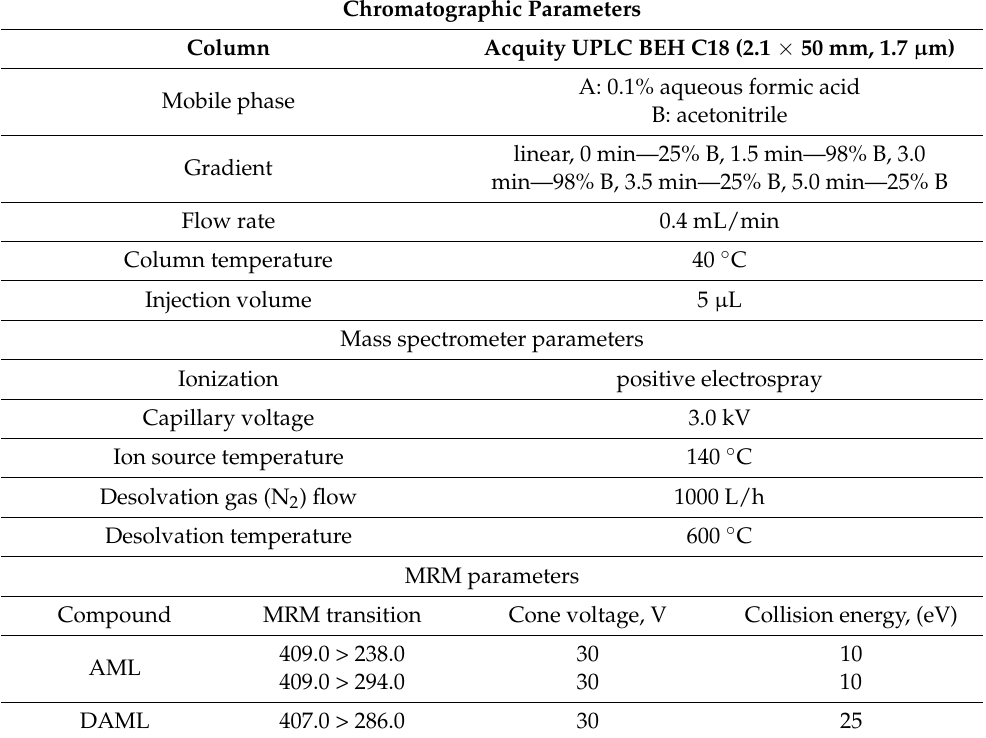
Table A1. Analytical